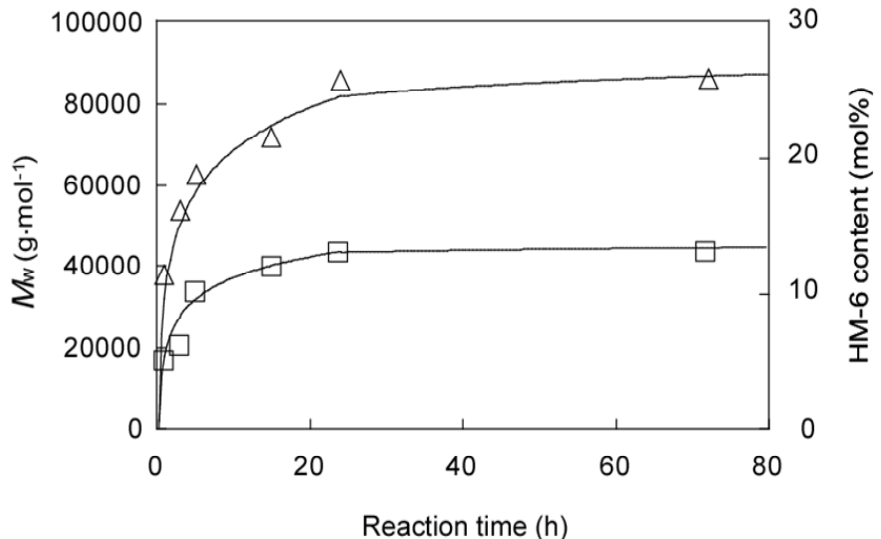
Figure 1. Time course of M ( △ ) and HM-6 content ( □ ) of PHS/M-6 (HM-6 feed ratio: 25 w